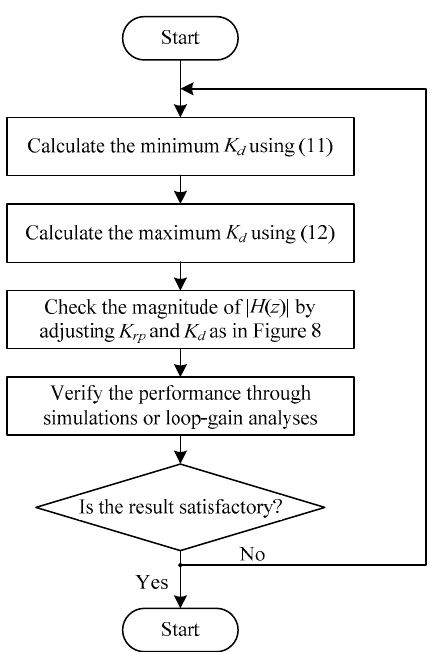
Figure 9. Design procedure of the active damping and the repetitive control gains.